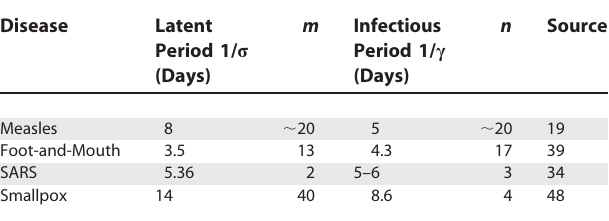
Table 1. Estimates of Latent and Infectious Period Durations Estimated from Data for a Number of Infections, Together with the Associated Gamma-Distribution Parameter ( m and n )